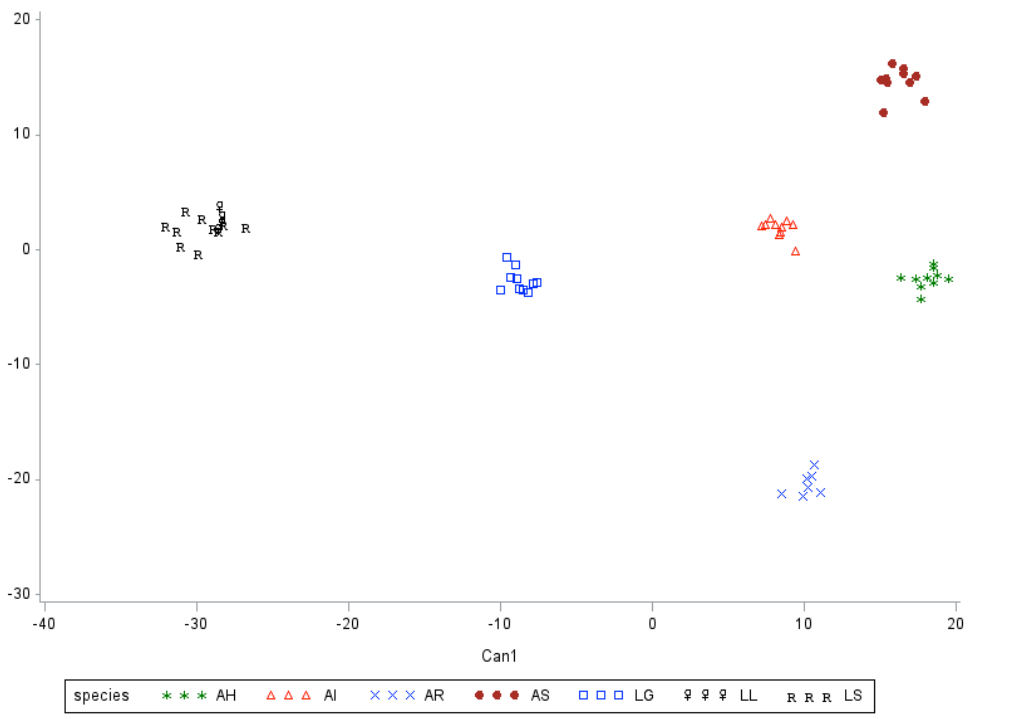
Figure 3. Scatter plot of first two factors from discriminant function analysis for Arothron & Lagocephalus from southeastern India (cumulative variations: 85%).